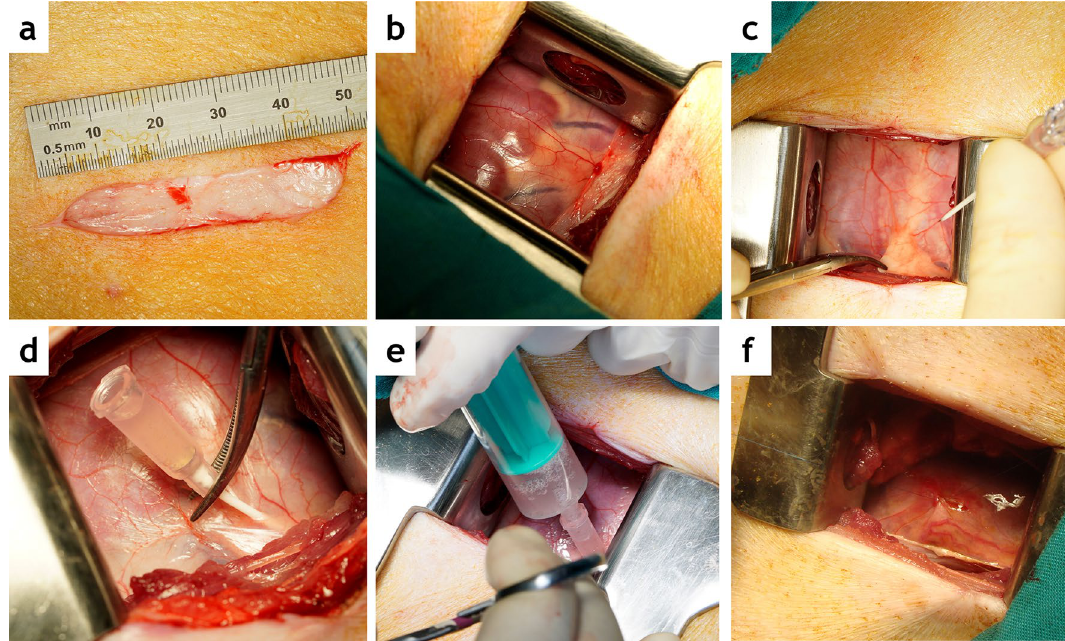
Figure 2. Surgical technique for intrapericardial administration. ( a ) 5 cm long skin incision in the left chest wall. ( b ) The heart is exposed through the mini-thoracotomy performed at the fourth or fifth intercostal space. ( c ) An 18G Abbocath catheter is inserted in the pericardial sac. ( d ) Pericardial fluid filling the hub of the catheter. ( e ) Injection is performed slowly. ( f ) If necessary, a 6/0 polypropylene suture is applied to the pericardial